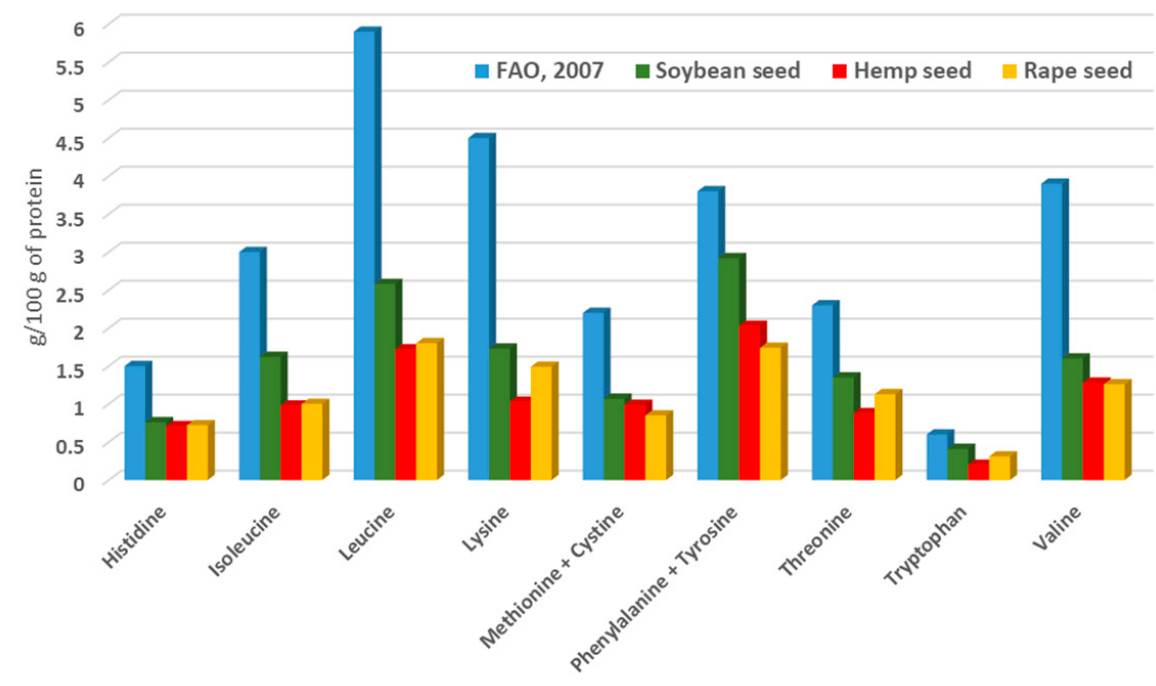
Figure 1. Content of essential amino acids (g/100 of protein) in soybean, hemp, and rape seed [9] in comparison with the reference pattern of FAO/WHO/ONU [2] for human nutrition.